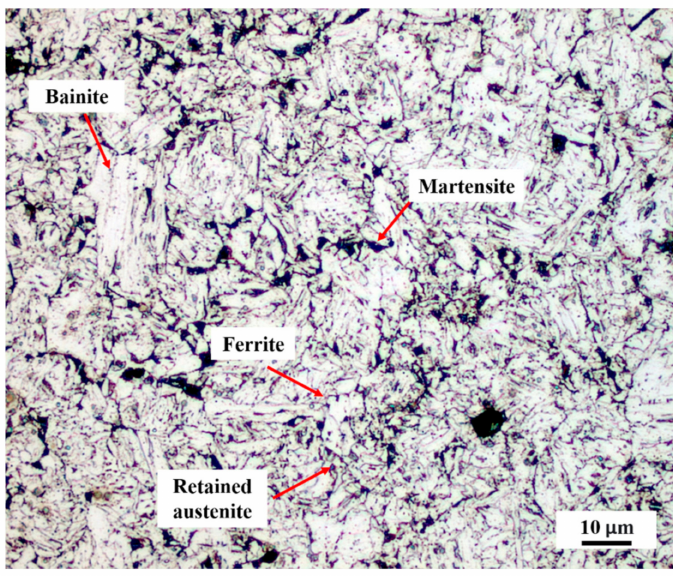
Figure 3. Microstructure of the BM CP